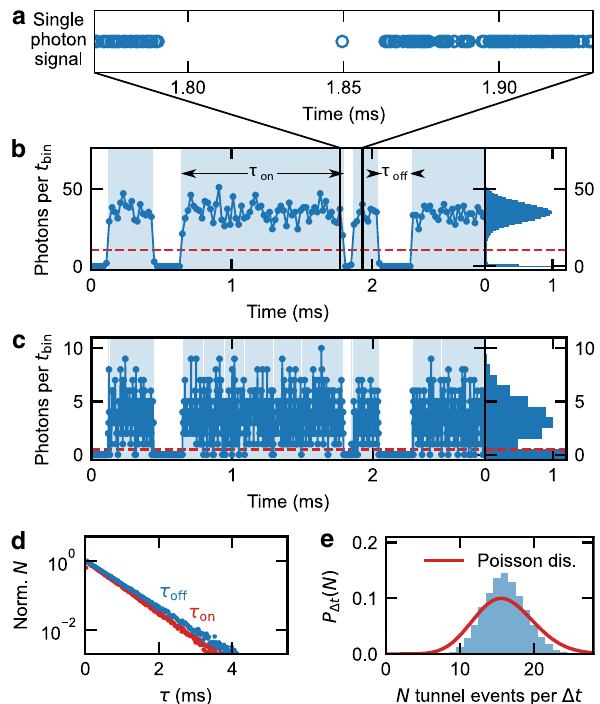
Figure 2. Evaluation scheme of the random telegraph signal (RTS). ( a ) Single photon stream from the resonant excitation of the exciton transition, recorded for about 5 min ( b,c ) Binned photon counts per t bin (left panel) and corresponding histogram (right panel) for two binning times t bin ( b t bin = 20 µ s ; c t bin = 2 µ s ). The charge state of the dot is determined by applying a threshold photon number (dashed red line). ( d ) The waiting-time distribution is evaluated by the length and frequency of the time periods of the on ( τ on ) and off state ( τ off ), respectively. ( e ) The full-counting statistics of the data in Fig. 2b, i.e. the probability to find N tunnel events in a given time period (cid:31) t = 20